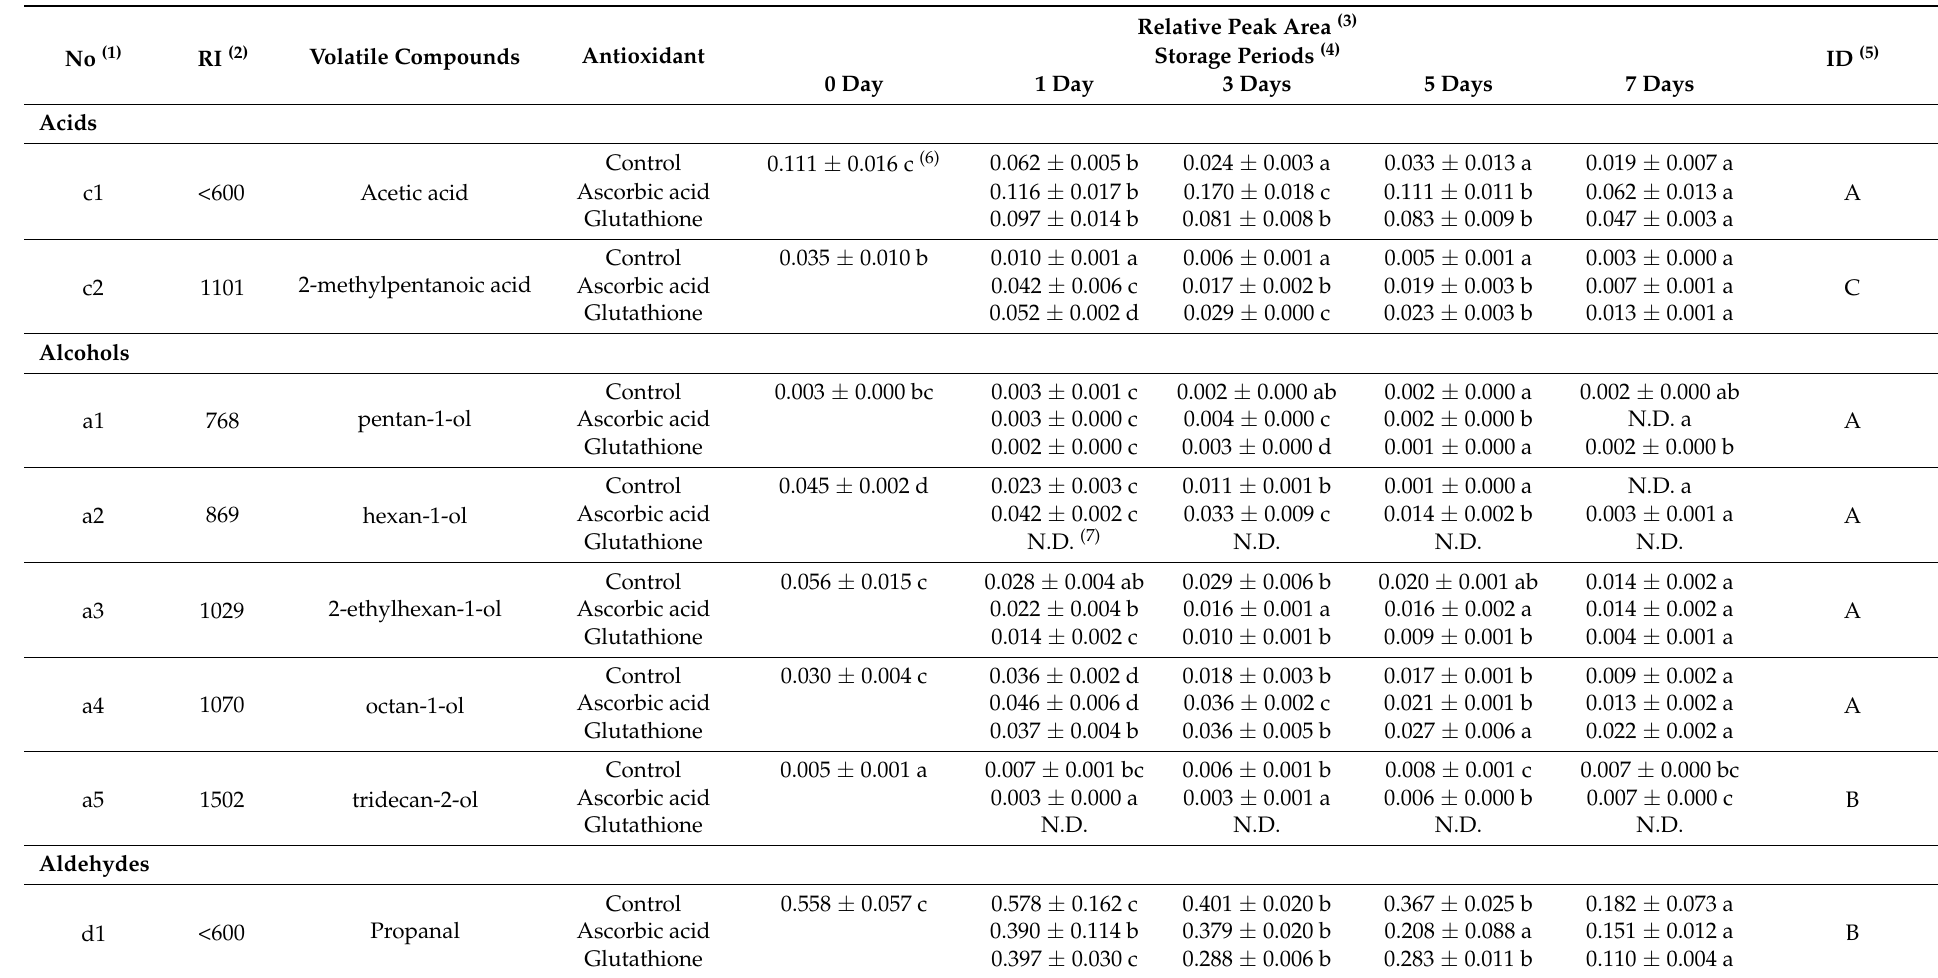
Table 2. Volatile compounds identified in the heated Welsh onion samples added with antioxidants during